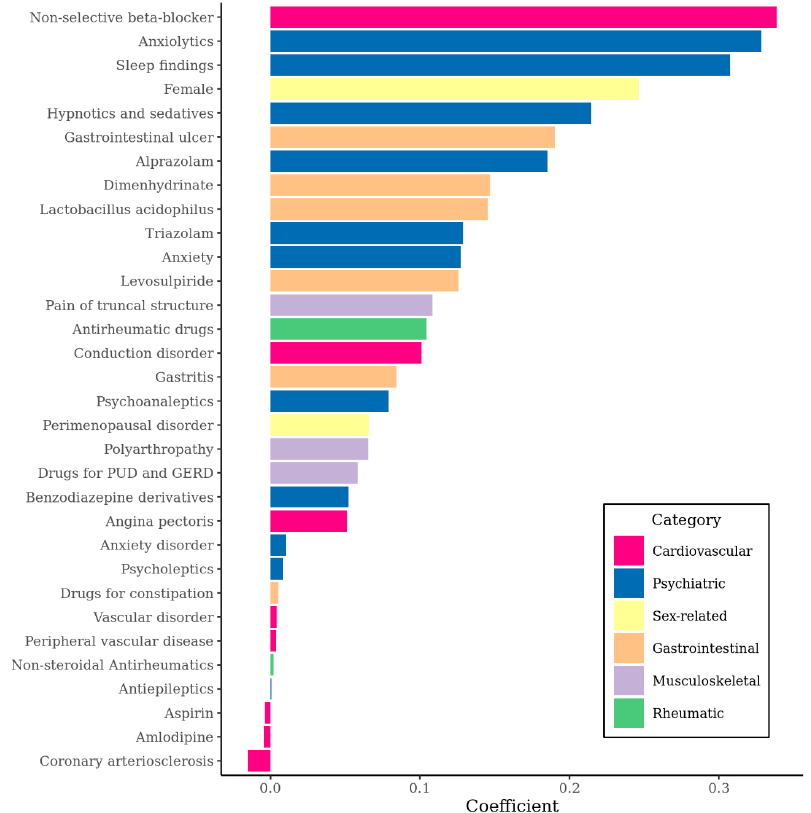
Figure 1. Coefficients of variables included in the developed model, as predictors for incident major depressive disorder. The higher coefficient means more predictive. PUD: peptic ulcer disease; GERD: depressive disorder. The higher coe ffi cient means more predictive. PUD: peptic ulcer disease; GERD: gastro-esophageal reflux disease. gastro-esophageal reflux